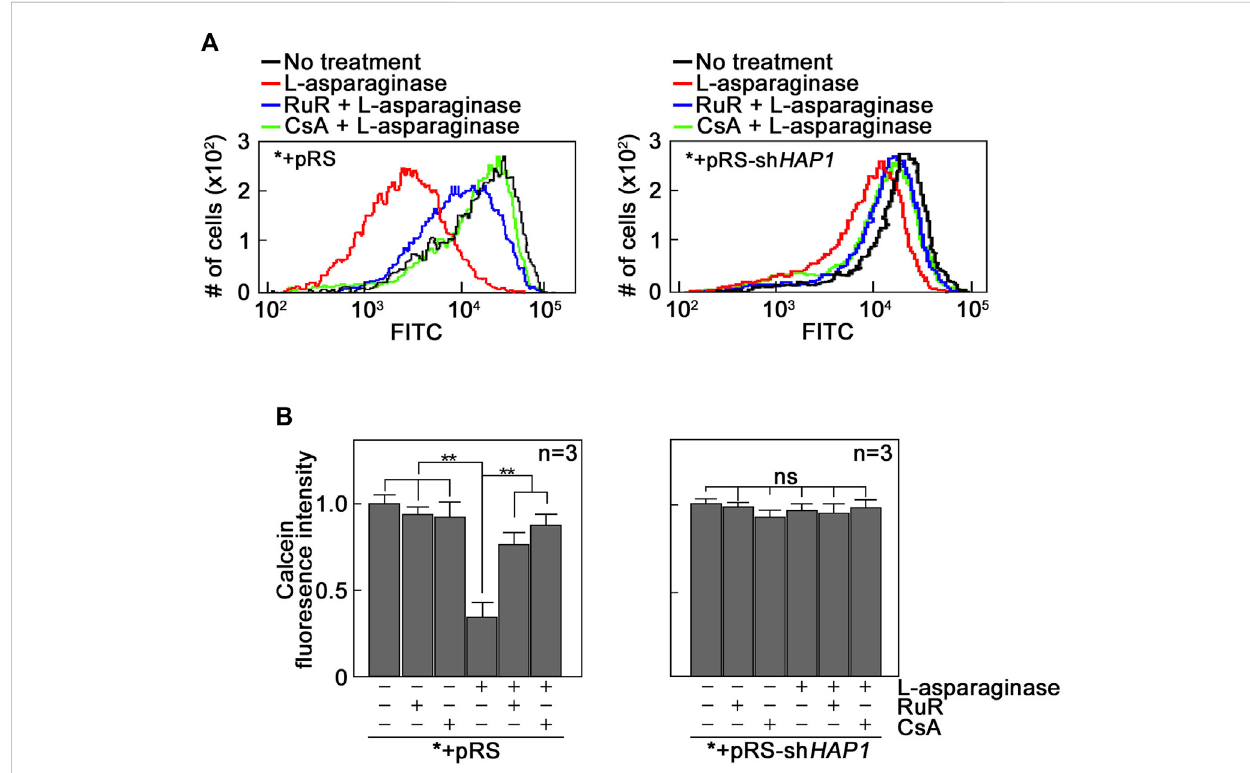
FIGURE 2 TheMCUchannelisinvolvedinL-asparaginase-inducedmPTPformation.*+pRSand*+pRS-sh HAP1 cellsloadedwithcalcein-AMthenpre-treated with RuR or CsA were stimulated with L-asparaginase then treated with CoCl 2 . Quantitative analysis of the relative calcein fl uorescence in *+pRS and *+pRS-sh HAP1 cells was performed by fl ow cytometry. (A) Data are from one of three independent experiments showing similar results. (B) Readings from untreated cells were normalized to 1.0. Values are means ± SEM from the three independent experiments ( n = 3). ** p < 0.05.